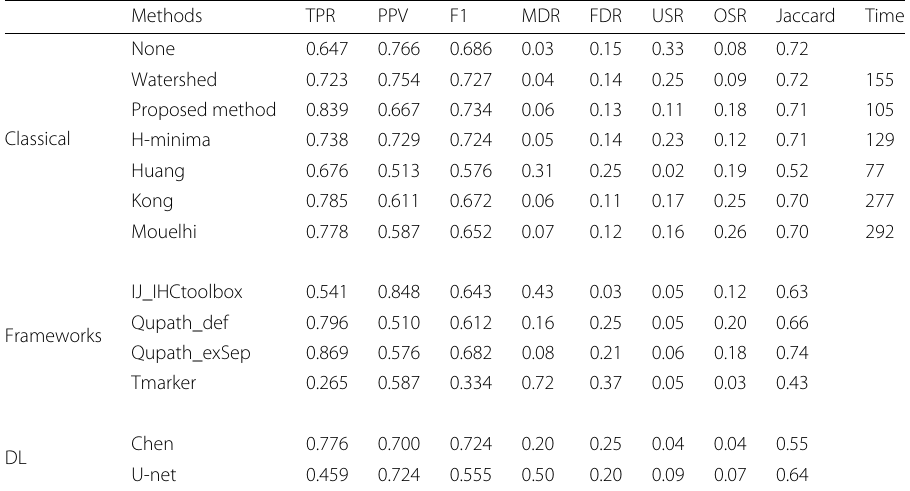
Table 3 Performance of the proposed method in comparison to the state-of-the-art frameworks Methods TPR PPV F1 MDR FDR USR OSR Jaccard Time None 0.647 0.766 Watershed 0.723 Classical